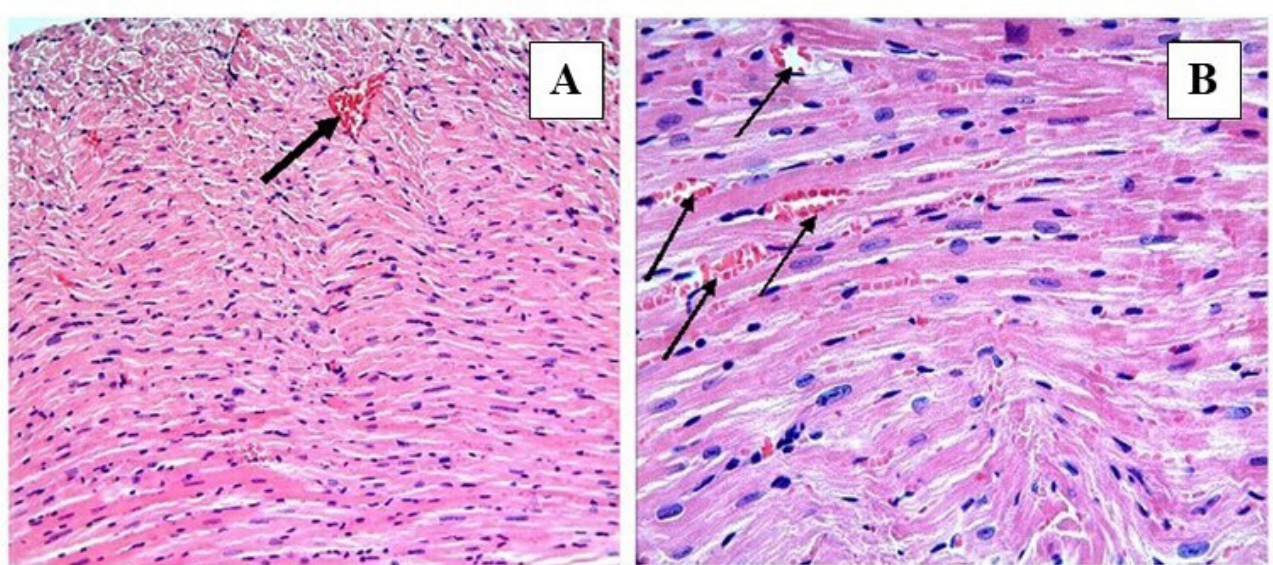
FIGURE 3 - L ittle vascular congestion (black arrow) (A), hemorrhage (thin black arrow) (B) observed in 18 β -GA+I/R group. A: H-E; X20, B: H-E; X40.